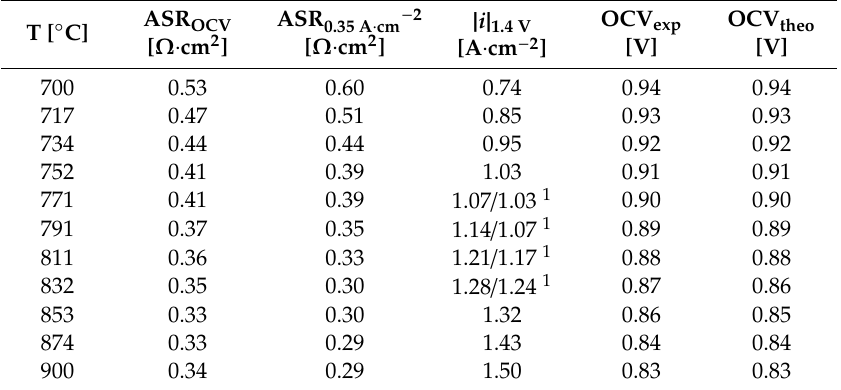
Table A2. ASR, | i | 1.4 V and OCV for various temperatures for the ratio of CO 2 :CO of